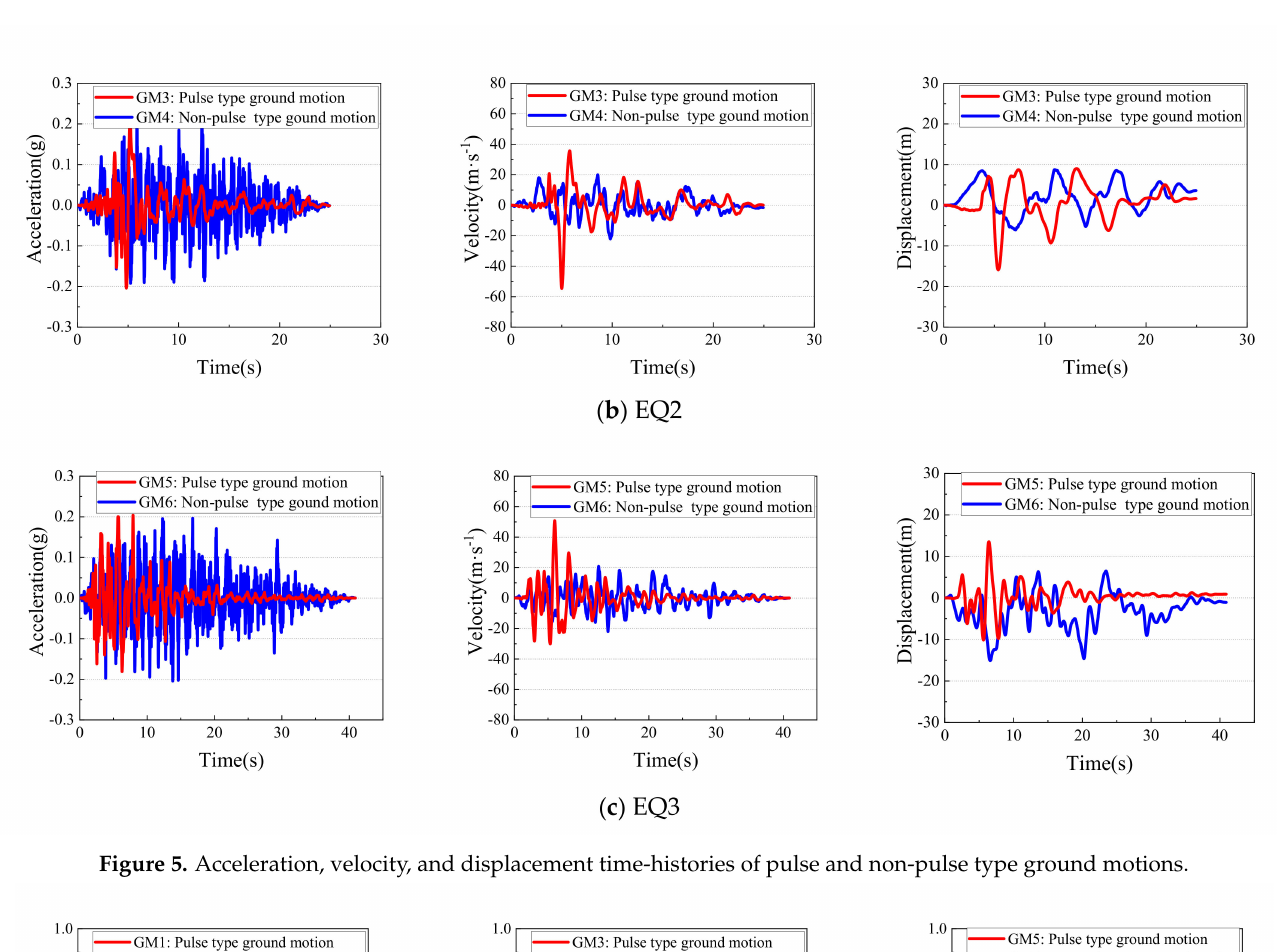
Figure 5. Acceleration, velocity, and displacement time-histories of pulse and non-pulse type ground motions.